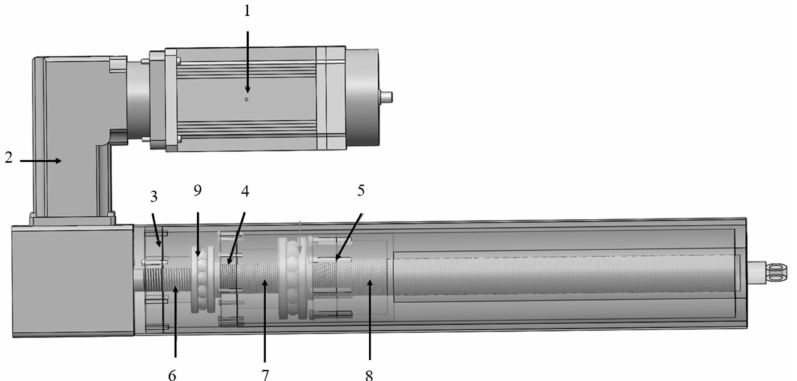
Figure 1. Schematic diagram of three-stage EMA. 1-PMSM, 2-Reducer, 3-Primary Nut, 4-Secondary Nut, 5-Tertiary Nut, 6-Primary Main Lead Screw, 7-Secondary Hollow Lead Screw, 8-Tertiary Hollow Lead Screw, 9-Thrust